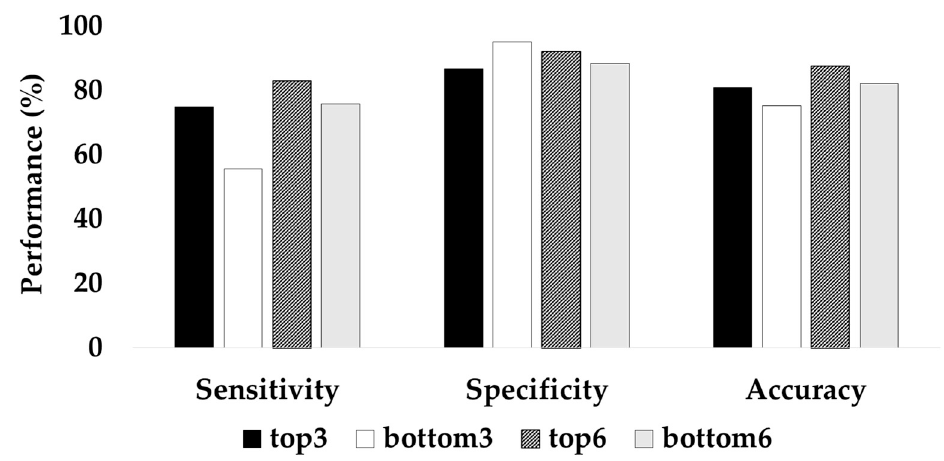
Figure 5. Classification accuracy of the CGRU model with reduced channels based on the attention score.